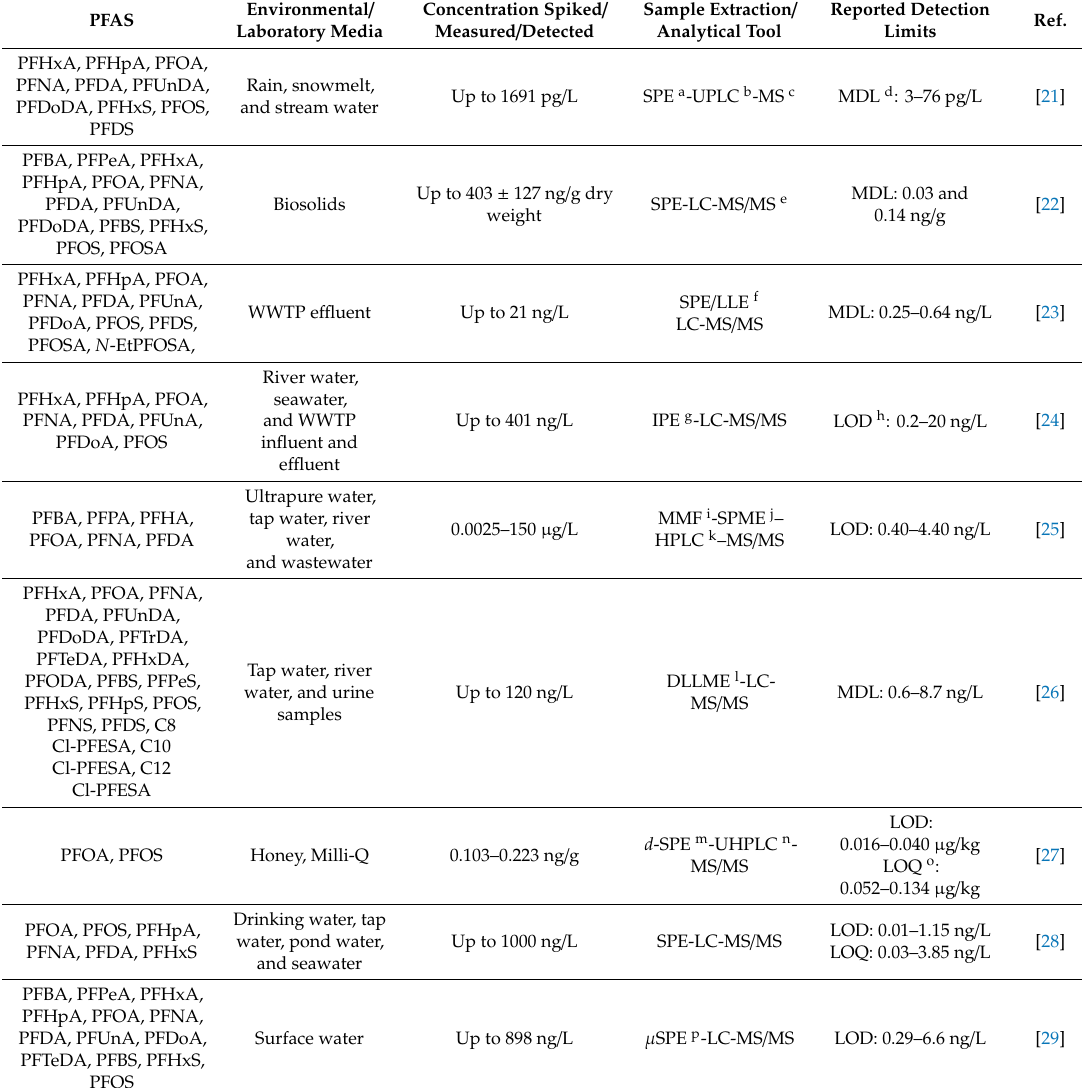
Table 1. Current analytical tools for per- and poly-fluoroalkyl substance (PFAS) measurements in various environmental matrices. Environmental / Concentration Spiked / Sample Extraction / Reported Detection PFAS Laboratory Media Measured / Detected Analytical Tool Limits